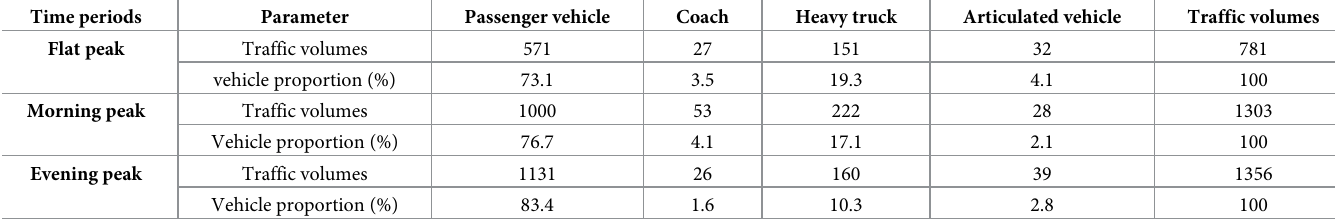
Table 1. Traffic volumes and vehicle proportion at three different time